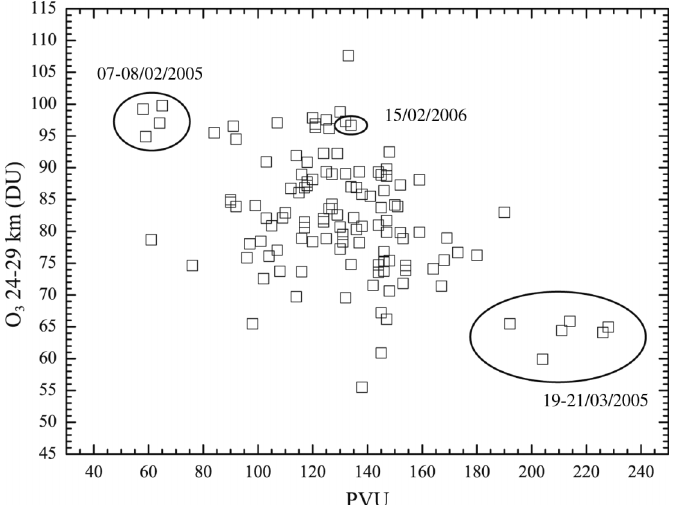
Fig. 9. Correlation scatterplot between Testa Grigia GBMS column density values between 24 and 29 km alti- tude (in Dobson Units) and averages of Potential Vorticity values along 15-day back trajectories at 650 K ( ∼ 27 km altitude). Specific dates are circled and indicated in the figure (see text for details). PVU stands for Poten- tial Vorticity Unit with 1 PVU = 10 − 6 Km 2 kg − 1 s − 1 .